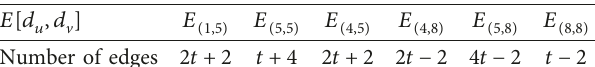
E E E E E ( 1 , 5 ) ( 5 , 5 ) ( 4 , 5 ) ( 4 , 8 ) ( 5 , 8 ) ( 8 , 8